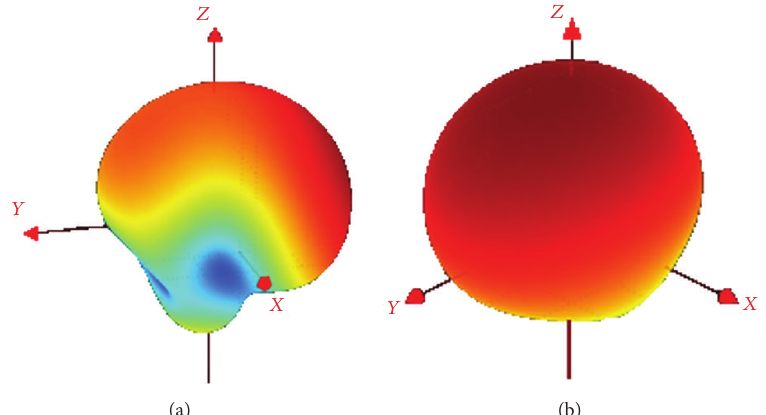
Figure 9: Measured 3D radiation patterns of the prototype single NFRP element reconfigurable antenna. (a) State 1 at 𝑓 𝑅 = 1.59 GHz and (b) State 2 at 𝑓 𝑅 = 1.76 GHz.